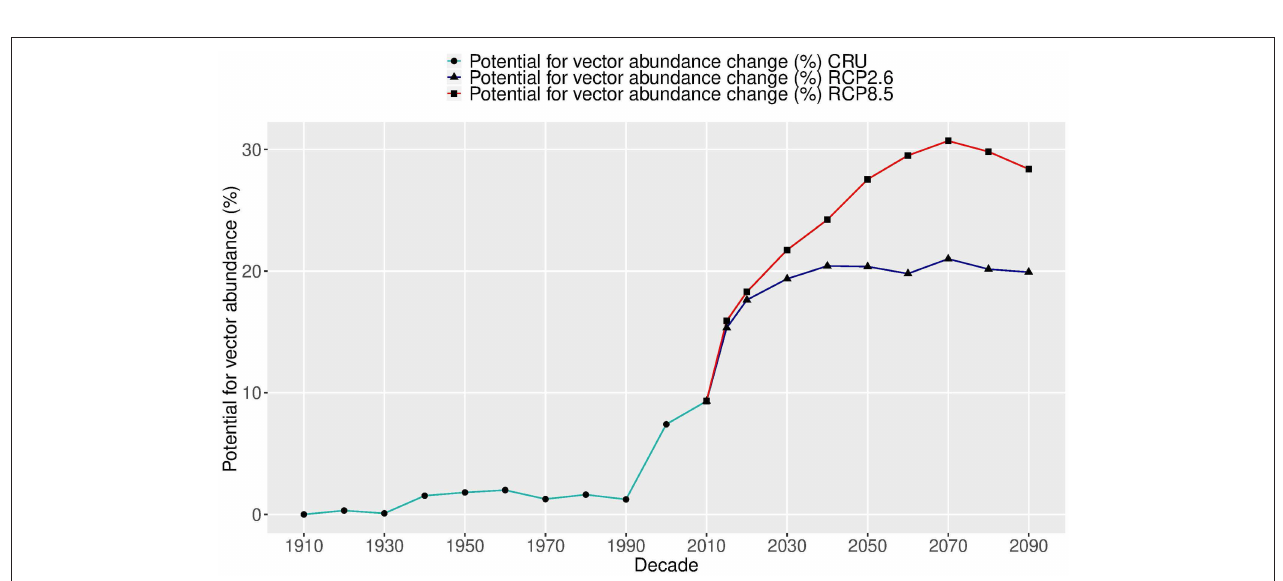
FIGURE 4 | Relative changes (%) in the global potential abundance of Aedes aegypti over two centuries (1905–2099). The future change (starting in 2015) shows two carbon emission scenarios: RCP2.6 (blue lines) and RCP8.5 (red lines), using five global climate model ensembles (CMIP5) based on Model A.